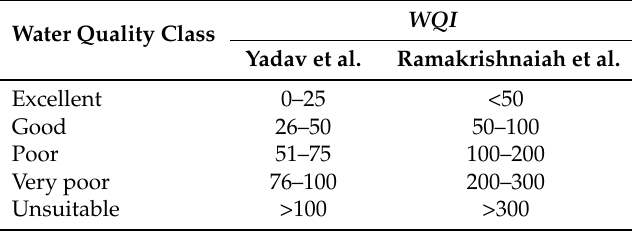
Table 2. Different Water Quality Scales based on the same WQI used by Sharma et al. [60]. WQI Water Quality Class Yadav et al. Ramakrishnaiah et al. 0–25